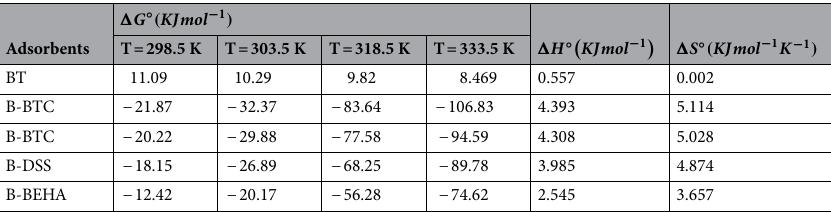
Table 3. Thermodynamic parameters for the adsorption of Dibenzothiphene (DBT) on modified clay.